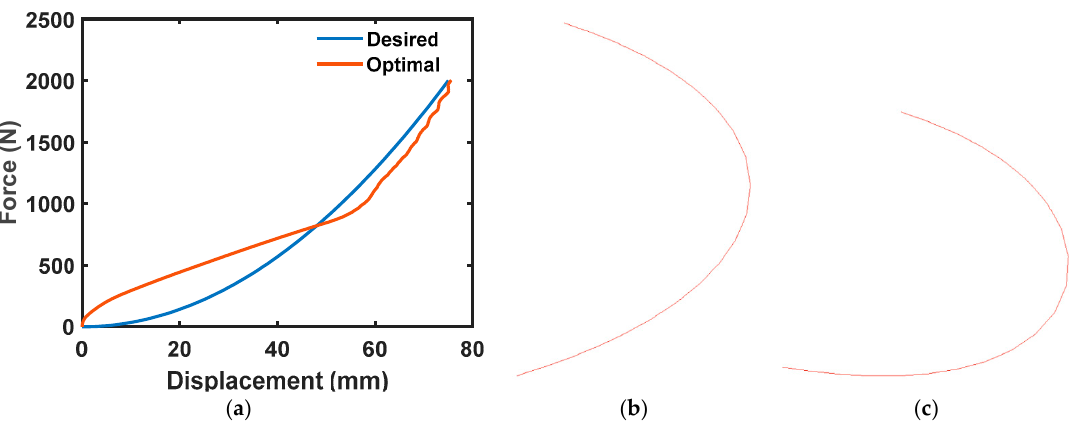
Figure 5. ( a ) Force-displacement characteristics of the prosthesis with hardening characteristics. ( b ) Initial shape of the optimized prosthesis with hardening characteristics. ( c ) Deformed shape of the optimized prosthesis with hardening characteristics under force 2000